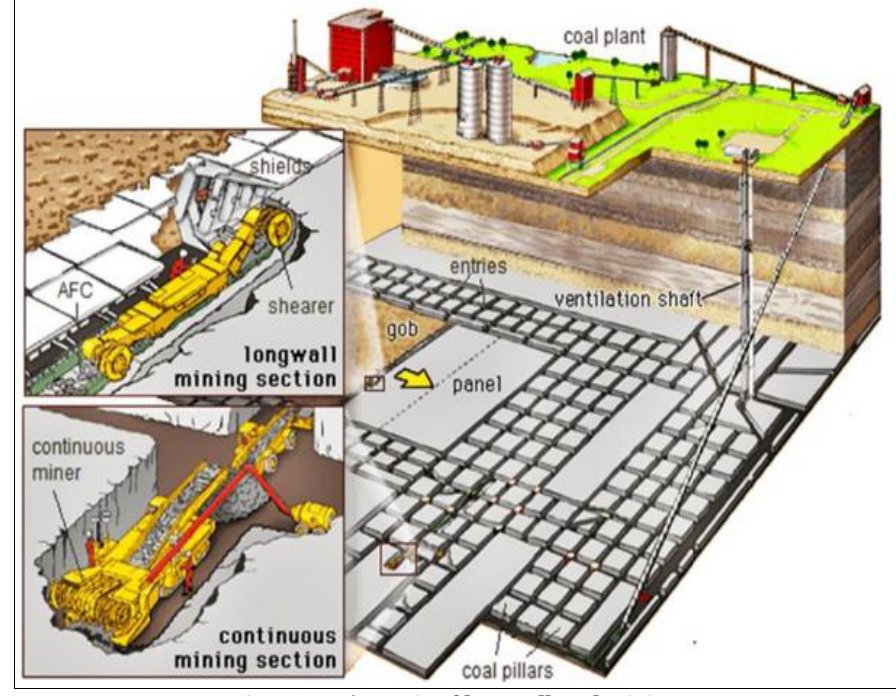
Figure 1: Schematic of longwall coal mining.